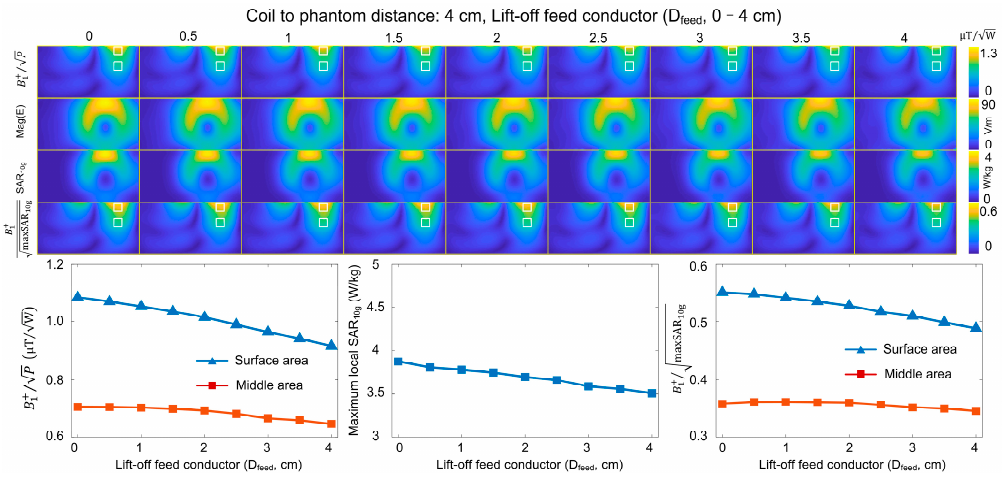
Figure 8. Simulated B 1+ efficiencies, E-fields, local SARs, and B 1+ SAR efficiencies of self-decoupled coils with different lift-off distances of the feed conductor (D feed ) and coil-to-phantom distance equal to 4